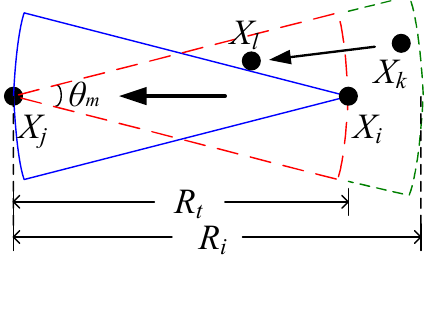
Figure 2. The Interference